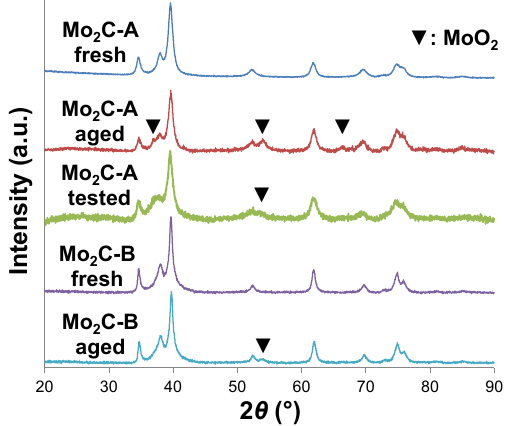
Figure 1. XRD patterns of two Mo 2 C samples (A and B) before and after aging for 48 h in hot liquid water. The pattern for Mo 2 C-A obtained after a 48 h aqueous-phase hydroprocessing run (10% guaiacol in water as feed) is also presented for comparison (Mo 2 C-A